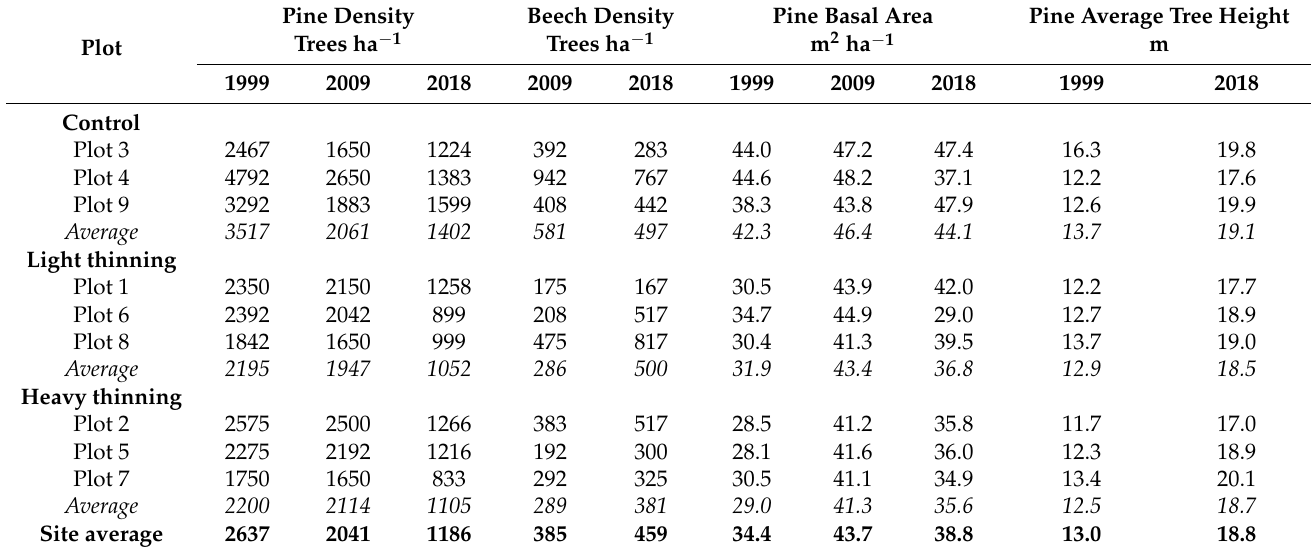
Table 1. Canopy structural features for selected years: 1999 (after 1st thinning), 2009 (before 2nd Table 2018. (last available inventory). Average tree height measured as the average of 50 trees randomly selected in each